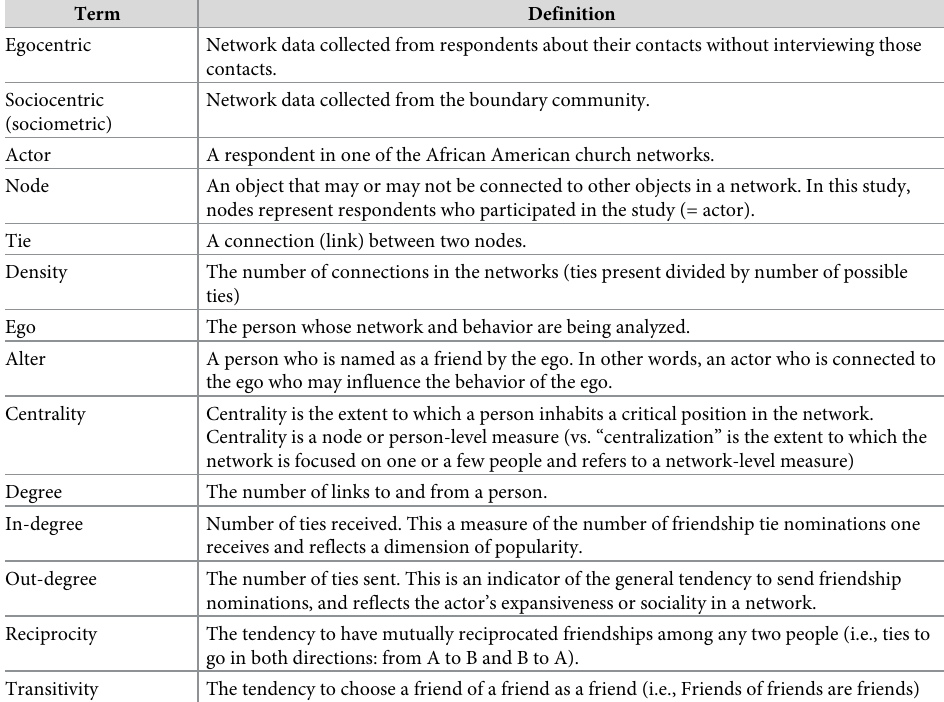
Table 1. Key terms and definitions used in this